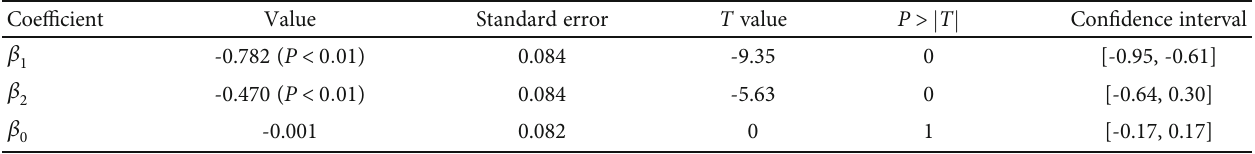
Table 3: Calculation results of regression coe ffi cients.